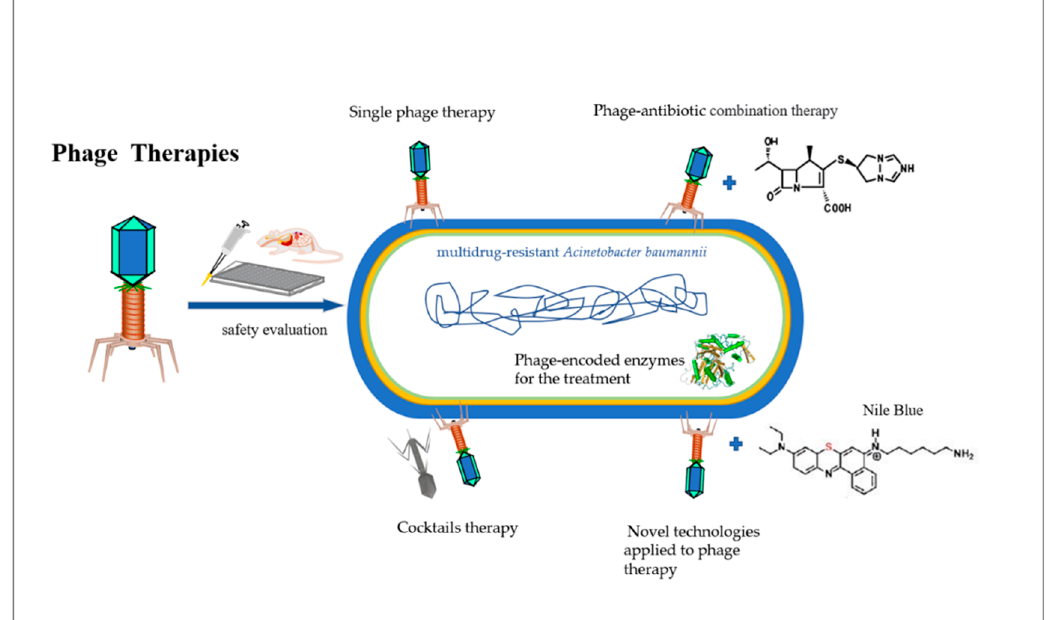
Figure 1. The most common phage therapies tested so far against pathogens, including single phage therapy, phage-cocktails, phage-antibiotic combination therapy, phage-encoded enzymes and novel approaches to phage therapy, such as its use in combination with photosensitizers.